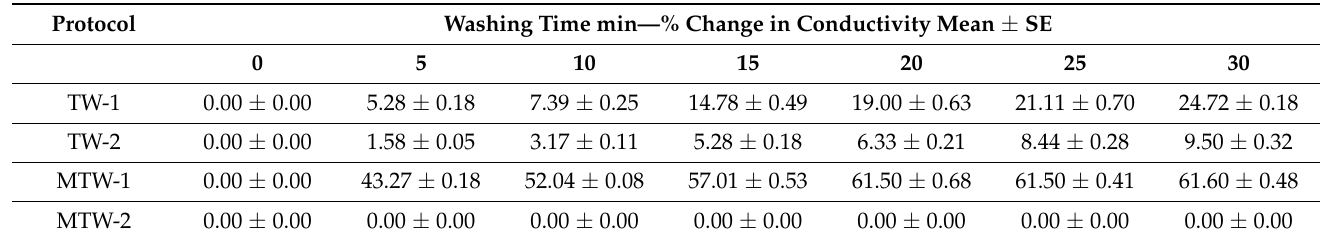
Table 2. First and Second Washing: Calculated % Change in Conductivity (Controls Table